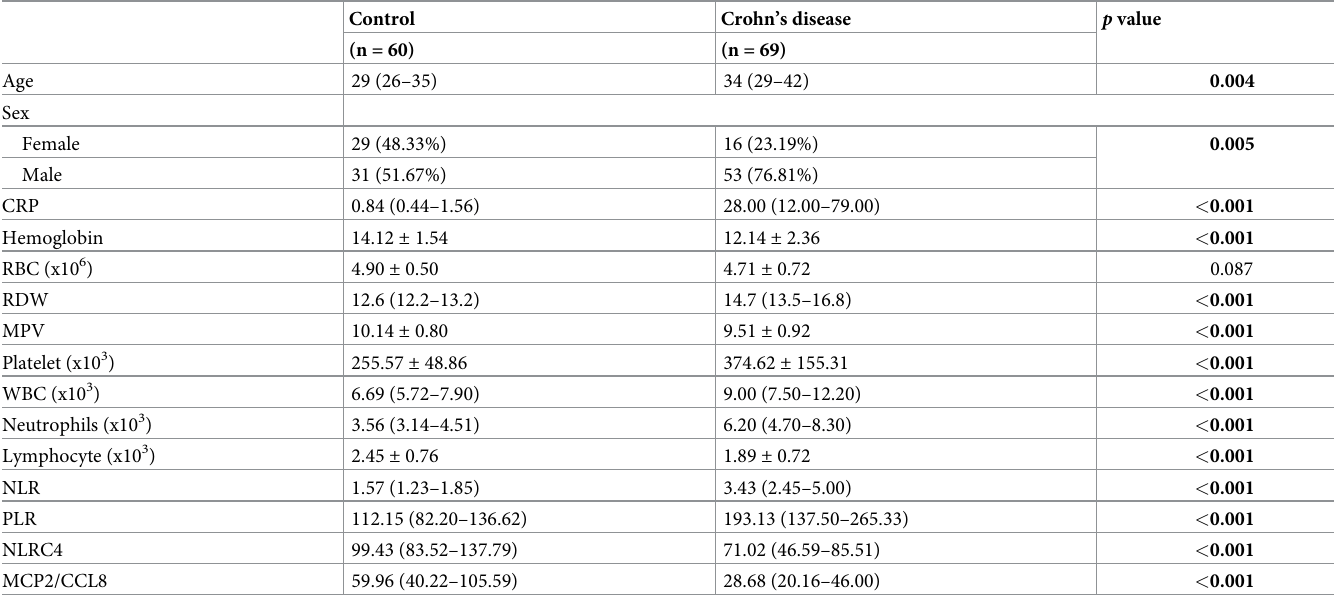
Table 1. Demographic and biochemical characteristics of participants.